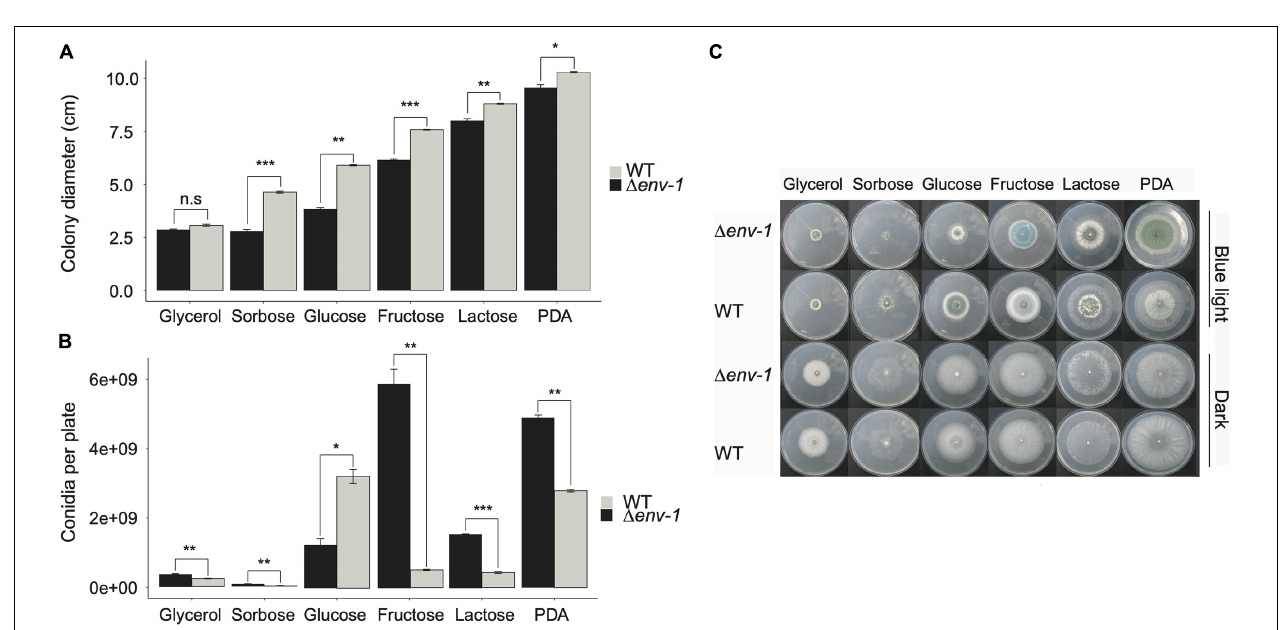
FIGURE 3 | Enrichment analysis biological processes in response to blue light in the WT strain and the photoreceptors mutants. (A,B) Significantly enriched Gene Ontology (GO) terms related to DNA, carbon and nitrogen metabolism in response to blue light in the indicated strain ( ∗ FDR < 0.05; ∗ FDR < 0.01). Each block (A) and horizontal bar (B) contains the up and down regulated functional categories.